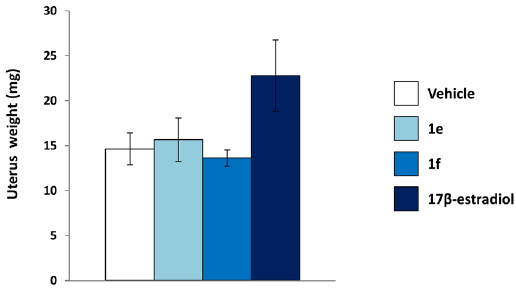
Figure 7. Uterus weight of ERE- Luc mice treated with synthetic and natural estrogens. Analysis of average weight of uterus of ERE- Luc mice after 6 hours of indicated treatment. Bars represent the mean ± SEM of uterus weigh measured in 4